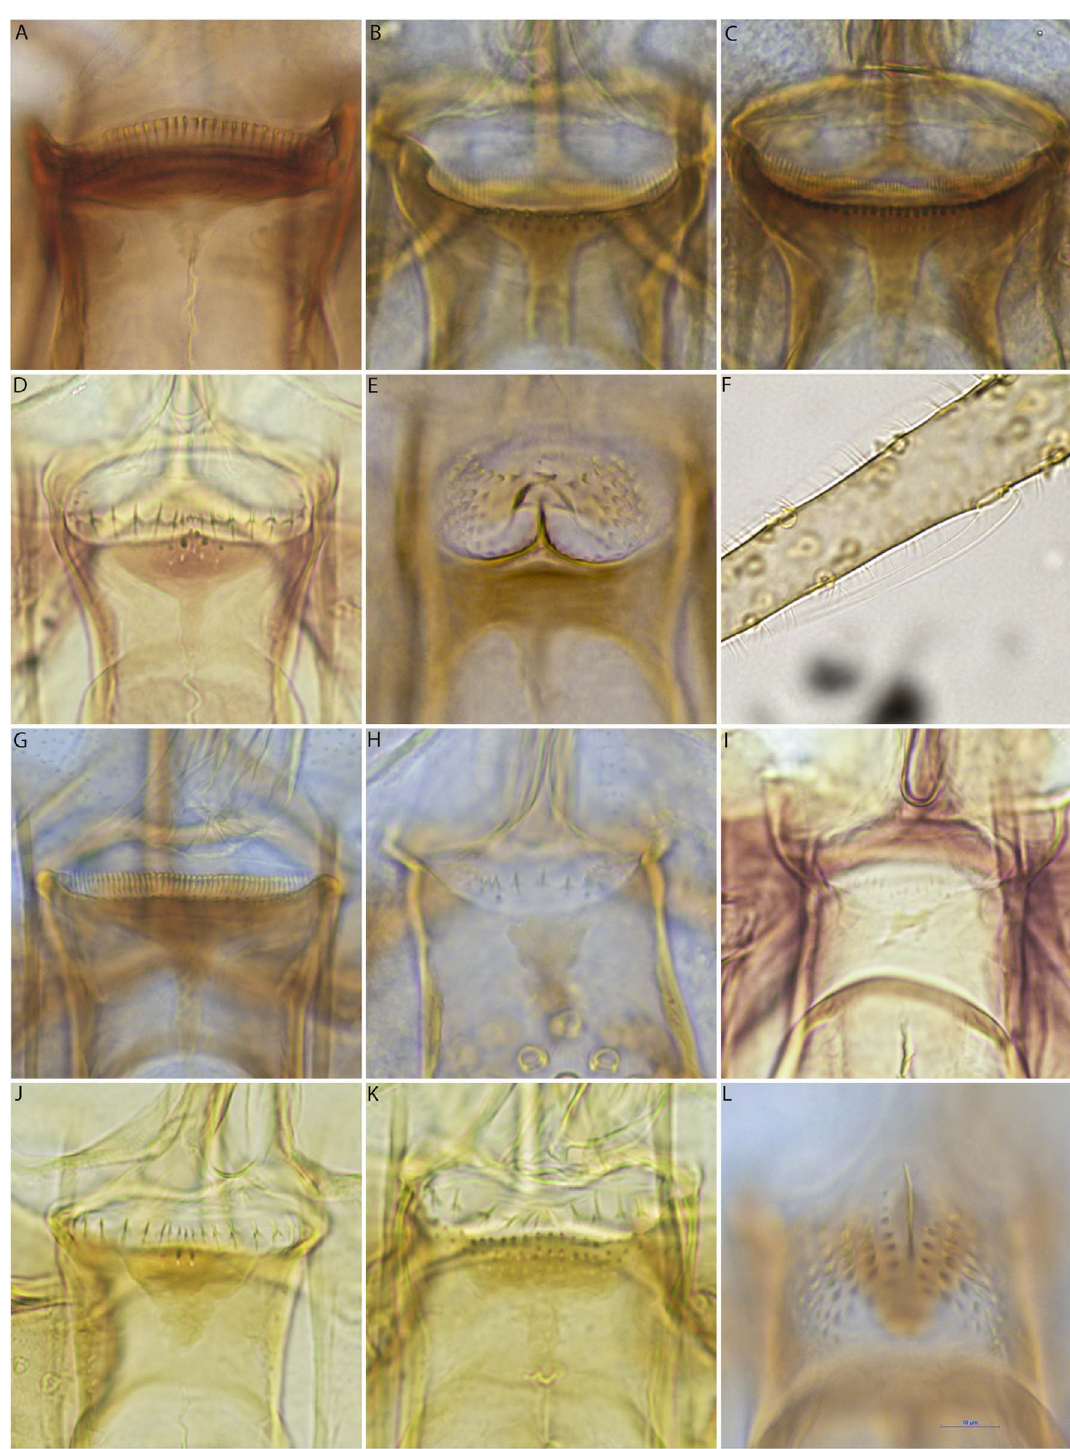
Figure 4. Microphotographs of cibaria of females of Grassomyia indica s. l . (A), the Sergentomyia barraudi group (B and C), Se. khawi (D), and the Se. anodontis group (E), ascoid of fl agellomere 3 of Se. sp.3 with a retrograde spur, cibarium of the Se. brevicaulis group (G), cibarium of Se. sylvatica (H), cibarium of Se. bailyi (I), cibarium of Se. hivernus (J), cibarium of the Se. perturbans group (K), cibarium of Idiophlebotomus sp . (L), all at the same